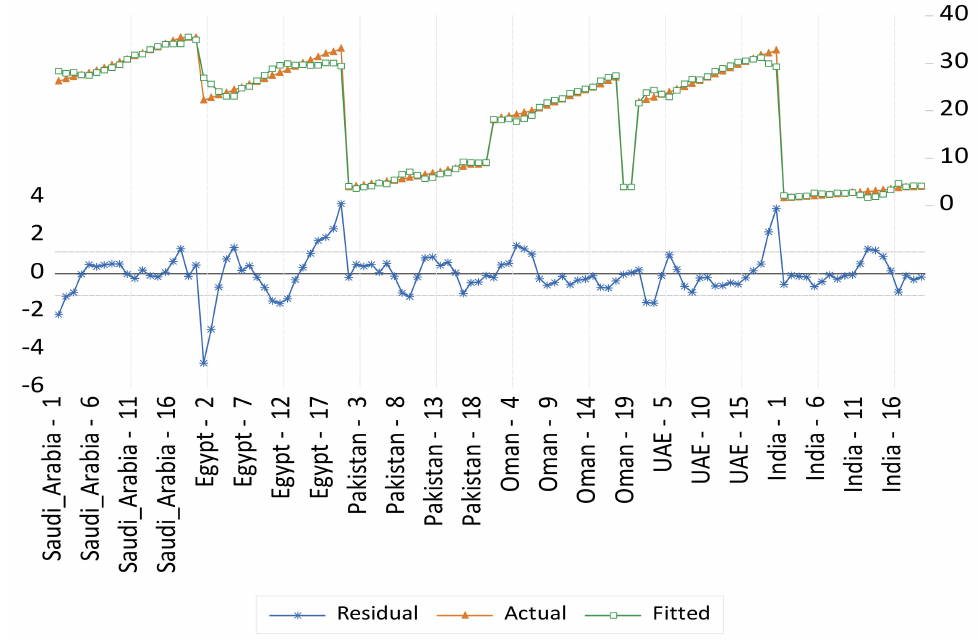
Figure 6. Actual, fitted, and residual of obesity in fixed-effect